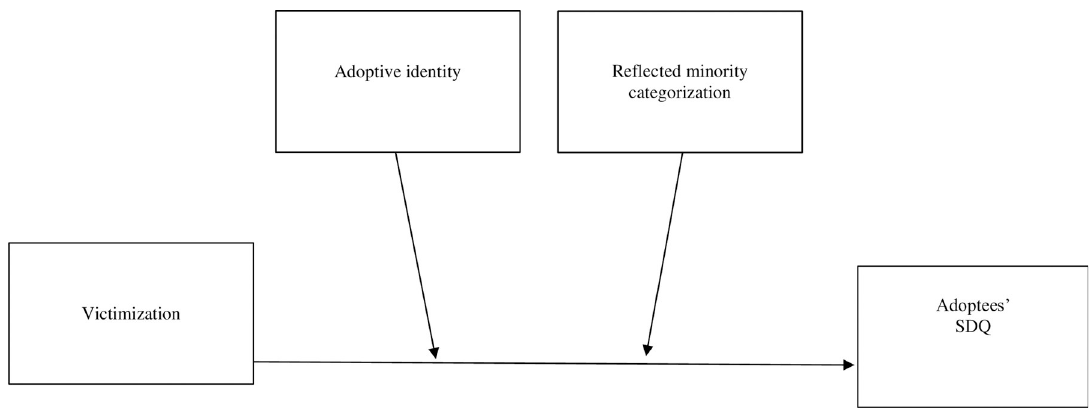
Fig 1. Theoretical moderation